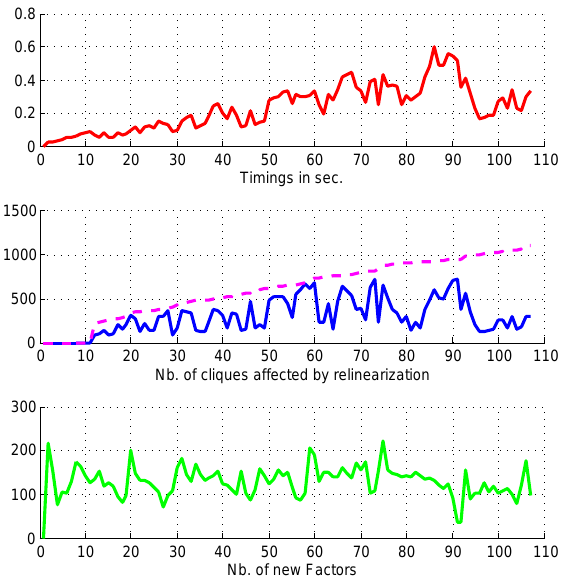
Figure 7: (a) Required time for processing incremental bundle adjustment using iSAM2. (b) Number of cliques related to re- linearized variables (solid) and the total number of cliques in the Bayes tree (dashed), note the effect on (a). (c) Number of new factors added, note that the number has no effect on (a).